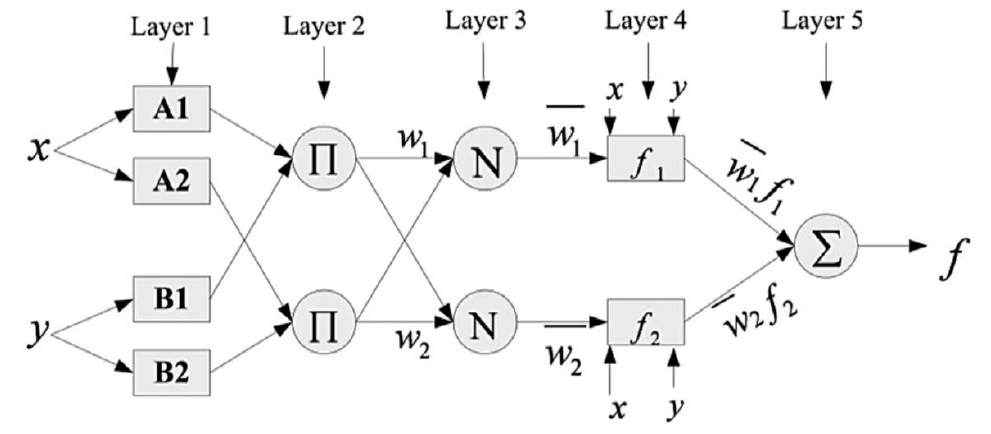
Figure 9. Basic architecture of ANFIS [123].